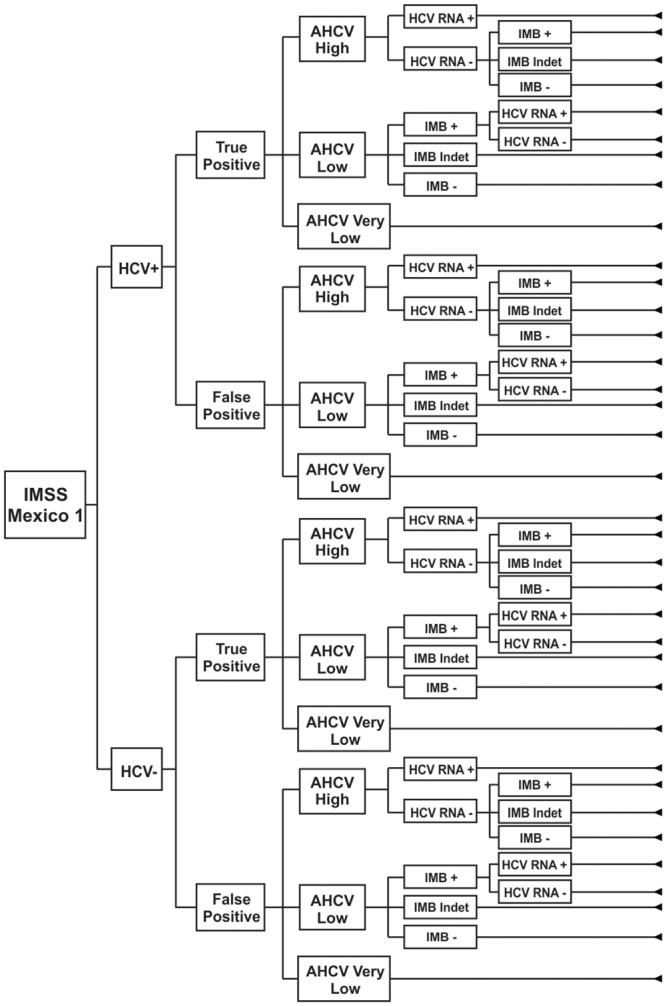
Decision tree for the IMSS-Mexico1 strategy.The decision tree describes first the situation of being HCV+ or HCV-, then situation of being a TP or a FP, then estimates the expected value of for each strategy of the tree.